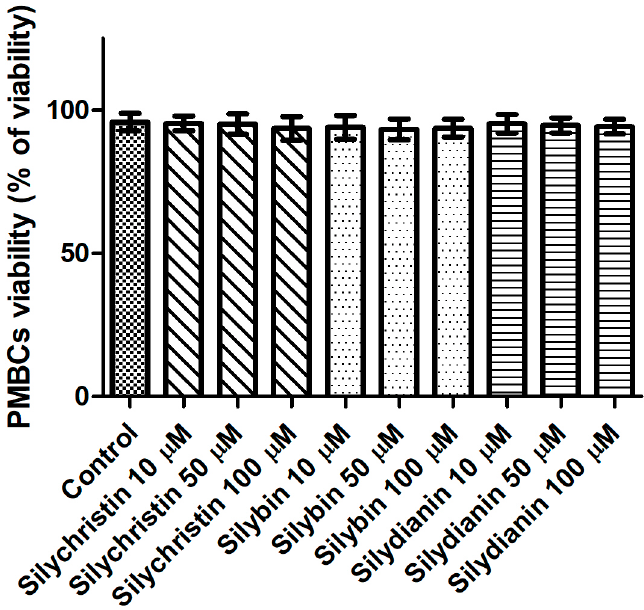
Figure 4. The effect of flavonolignans (silychristin, silybin and silydianin in concentrations of 10, 50 and 100 µM) on PMBCs viability. The data represent the mean of 8 measurements.